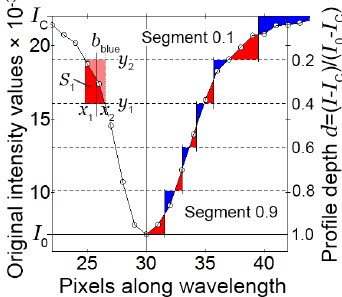
Figure 1. To the explanation of the bisector construction